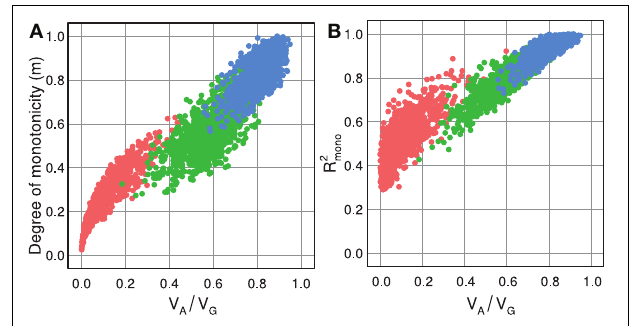
FIGURE A1 | Measures of monotonicity vs. additivity of GP maps with three loci. Scatterplots showing V A / V G from unweighted regression vs. (A) degree of monotonicity ( m ) and (B) R 2 mono . Red dots show 1000 random three-locus GP maps, blue dots show the same 1000 GP maps after sorting to introduce order-preservation for 1 locus while green dots show the same 1000 GP maps after sorting to introduce order-preservation for 2 loci [see Model and Methods in Gjuvsland et al. (2011)].